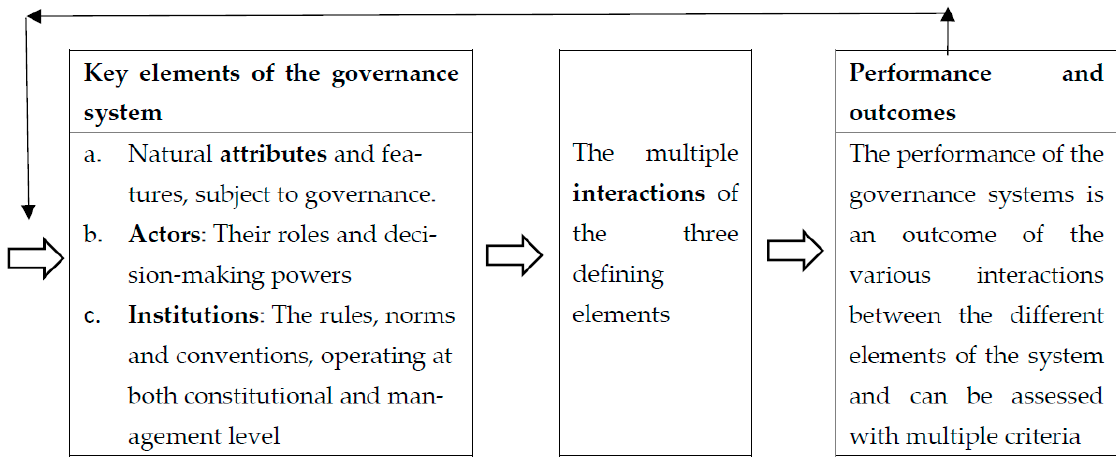
Figure 1. A natural resources governance system and its analytical elements (Adopted from Vatn, 2015).